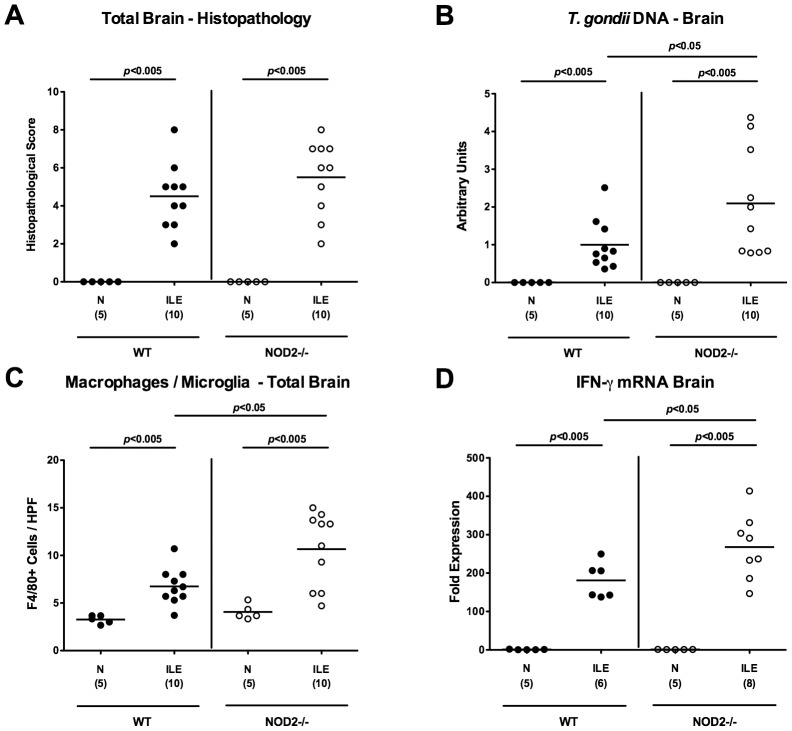
Intracerebral immunopathology in NOD2 deficient mice following ileitis induction.(A) Intracerebral histopathological changes (in cortex and meninges) were assessed in H&E stained brain paraffin sections applying a standardized score and (B) T. gondii DNA determined in ex vivo whole brain biopsies derived from C57BL/6 wildtype (WT; black circles) and NOD2 deficient (NOD2-/-; white circles) mice seven days following ileitis induction (ILE) by semi-quantitative RT-PCR and normalized relative to the M. musculus ASL gene (Arbitrary Units). Naive mice served as negative controls (N). Furthermore, (C) average numbers of macrophages and microglia (positive for F4/80) were quantified microscopically in six high power fields (HPF, 400× magnification) of brain paraffin sections per animal. (D) IFN-γ mRNA expression levels were determined in ex vivo whole brain biopsies by quantitative RT-PCR. Numbers of analyzed mice (in parentheses), means (black bars) and levels of significance (P-values) as compared to the respective groups (determined by Mann-Whitney-U test) are indicated. Data shown are representative for three independent experiments.